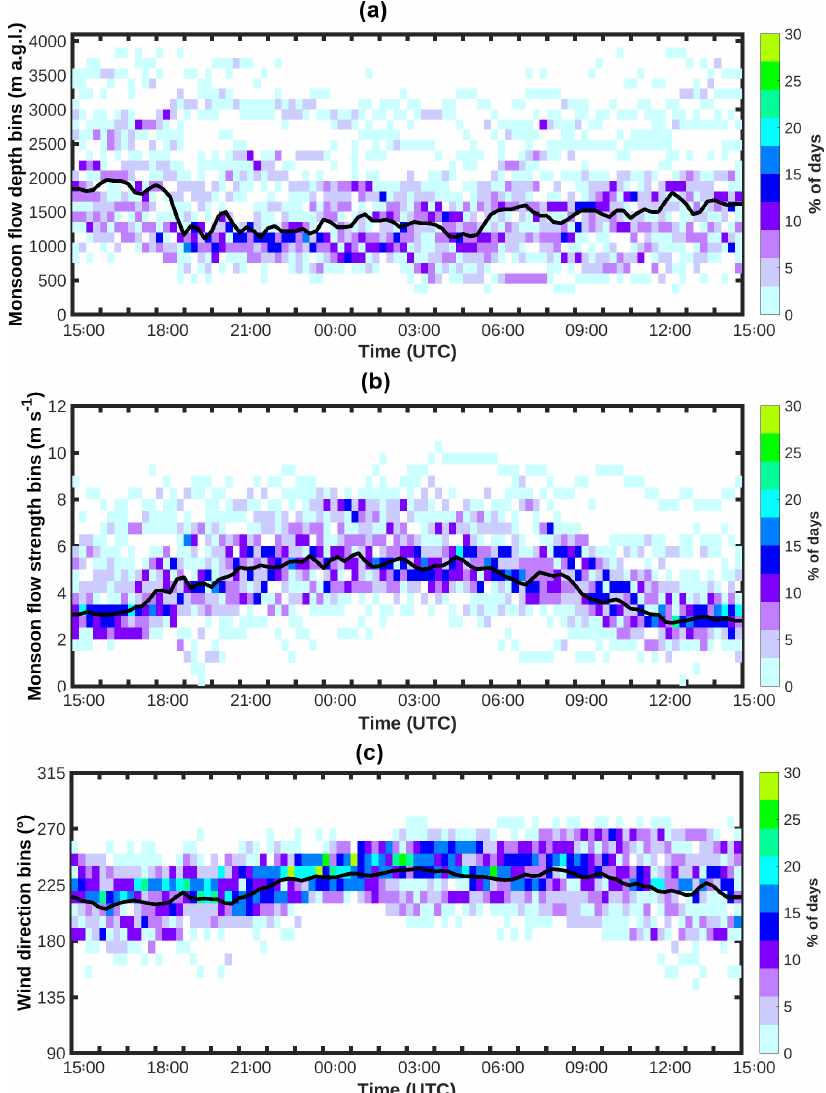
Figure 3. Temporal evolution of the distribution of the monsoon flow (a) depth, (b) strength and (c) direction at Savè for the period between 20 June and 30 July. The black lines in panels (a) , (b) and (c) indicate the median monsoon depth, strength, and direction,